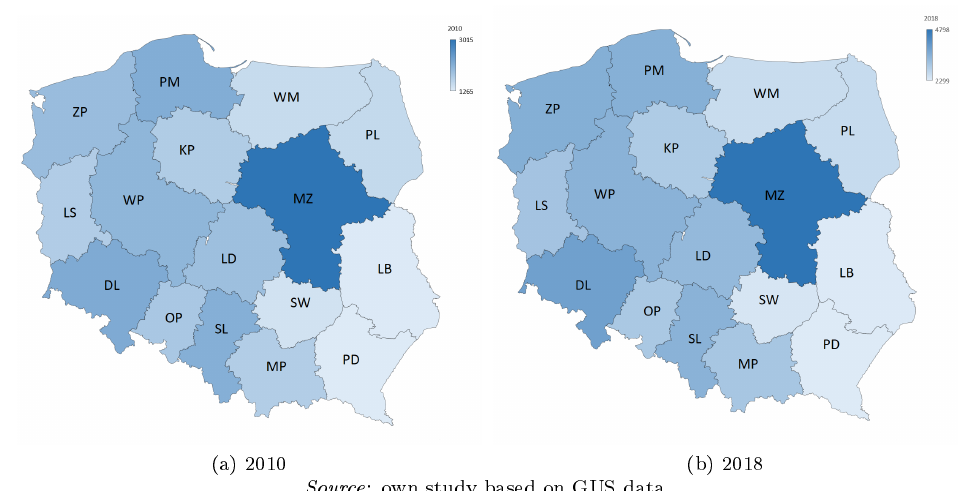
Figure 1: LGU tax revenue per capita by voivodeship in 2010 and 2018,